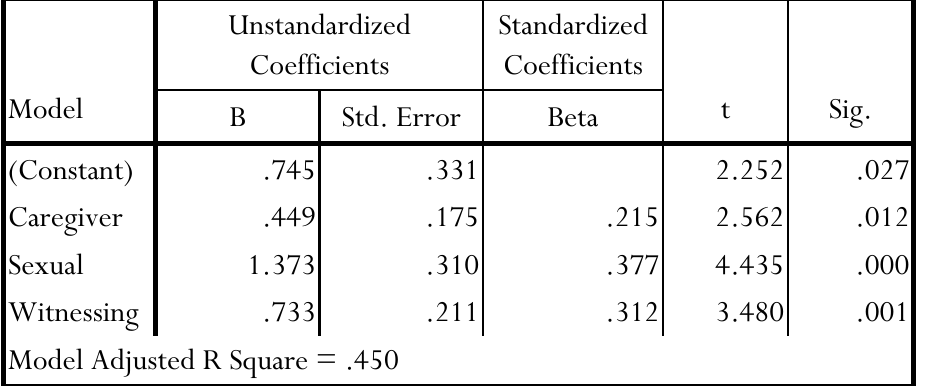
Table 15: Linear Regression of Number of Victimizations on Duration of Substance Use